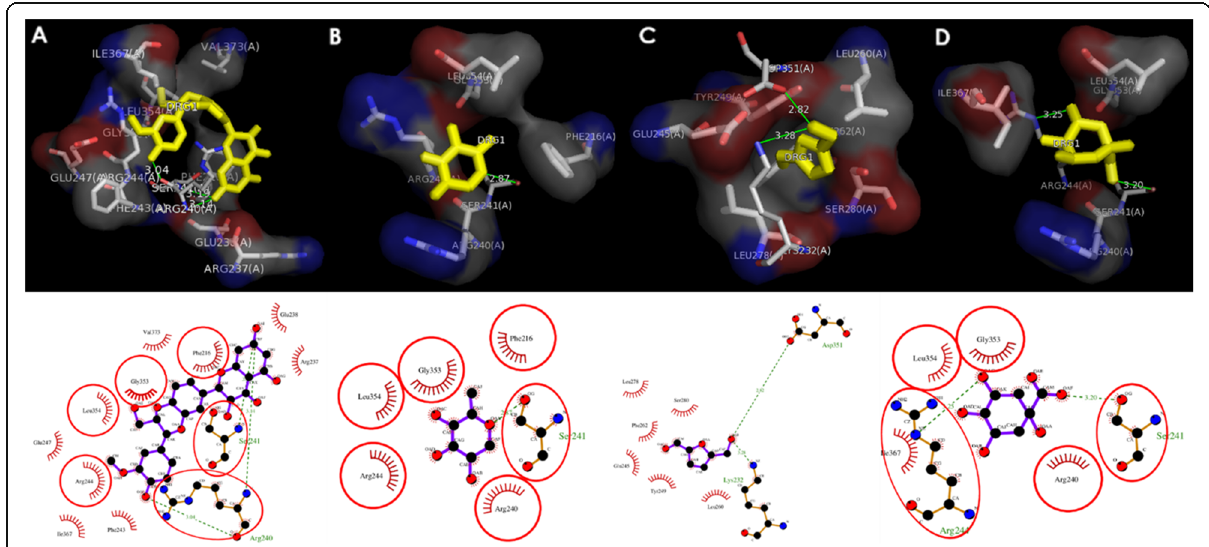
Fig. 6 Ligplot analysis and docking in relation to PPAR α . a crystal structure of PPAR α , ligand Silymarin (Standard drug), b , c , d Crystal structures of PPAR α with the ligands 2,3-Dihydro-3,5-dihydroxy-6-methyl-4 h-pyran-4-one, 2-furancarboxaldehyde 5-(hydroxymethyl)- and Quinic